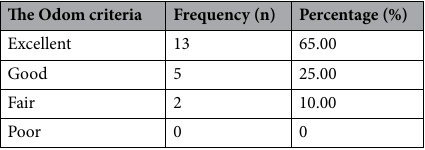
Table 2. Evaluation of surgical outcome according to Odom criteria.